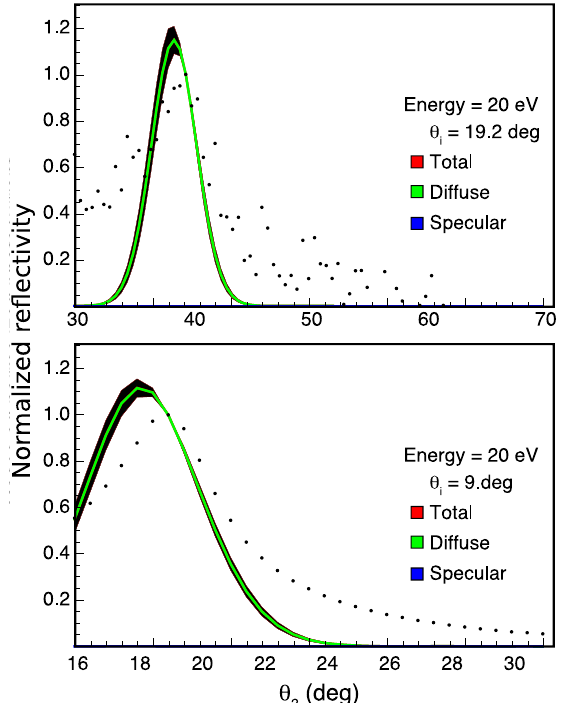
FIG. 28. Data sets Th9-Th10: Comparison between measure- ment and X-ray scattering model, θ 2 scans, for θ 1 ¼ 10 ° and θ ¼ 20 °, and 20 eV. The gray band represents the mean- 1 prediction 95% confidence level associated with the fit. The relationship between θ and θ 1 is given in Sec. VA. i